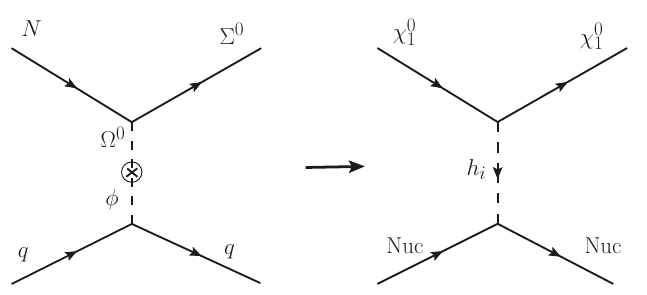
Figure 3 . SI process in the STFDM model. In the left, we show the process in the gauge basis. In the right, we show the process in the mass basis in order to emphasize that actually, we have two contributions coming from the Higgses h i